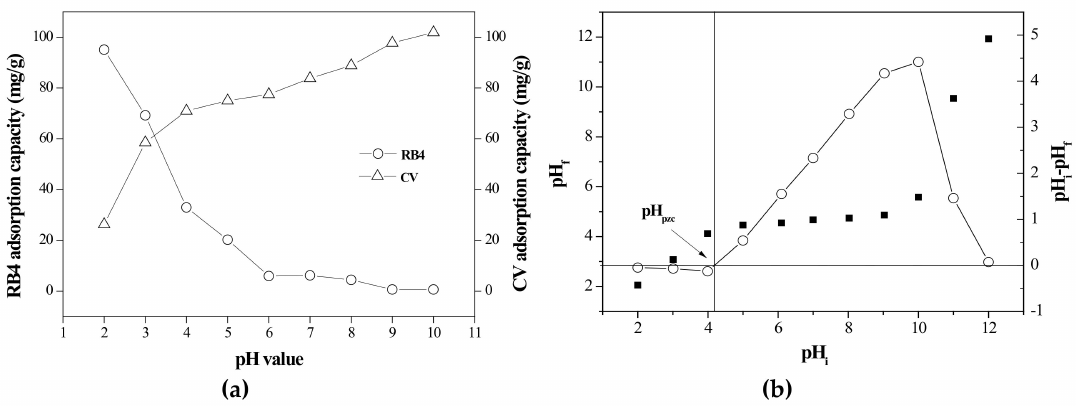
Figure 5. ( a ) pH e ff ect on dye removal in rice bran / SnO 2 / Fe 3 O 4 and ( b ) the determination of pH pzc of rice bran / SnO 2 / Fe 3 O 4 .